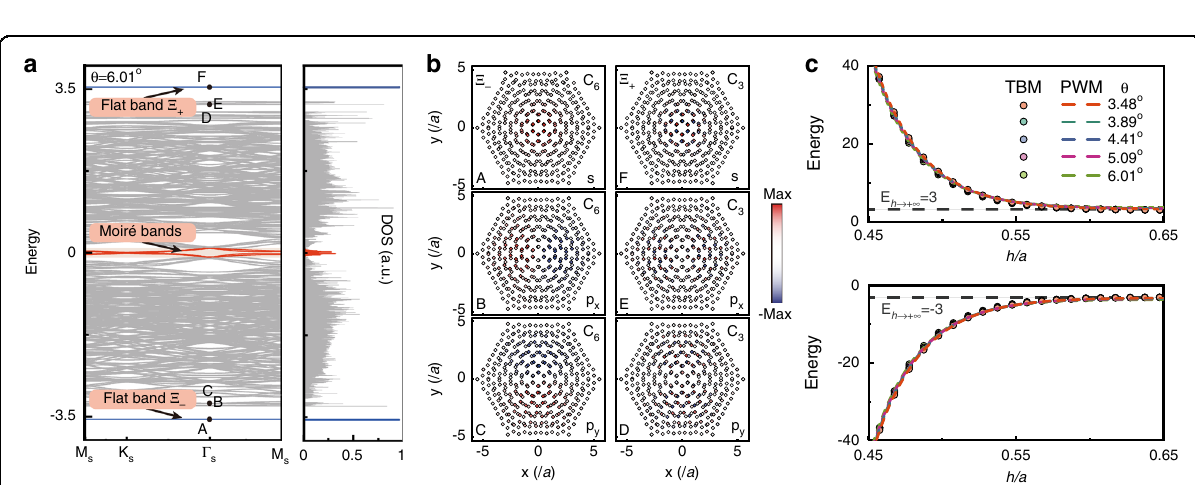
Fig. 5 Super fl at bands and corresponding localized states obtained by the tight-binding model method. a Band structures and related DOS ffiffiffi p 3 . Two super fl at bands ( Ξ − and Ξ + ) are labeled in blue located at lowest and highest energies with obtained by the TBM with θ = 6.01 ∘ and h ¼ a = extremely sharp DOS. Besides, typical moiré bands labeled in red appear around the zero energy with divergent DOS. b Various eigenstates for Ξ − and Ξ + bands and adjacent bands, which are arranged from the lowest to highest energy, i.e., A – F, corresponding to s , p x , y , ..., p x , y and s states. c The ffiffiffi p energies of super fl at bands that vary with h around a = 3 . Different cases of θ (i.e., 3.48 ∘ , 3.89 ∘ , 4.41 ∘ , 5.09 ∘ , and 6.01 ∘ ) have also been represented in different colors. Faint circles and dark dotted lines correspond to the results in TBM and PWM, respectively, while faint gray dotted lines indicate the bulk energies of AA stacked lattices for in fi nite